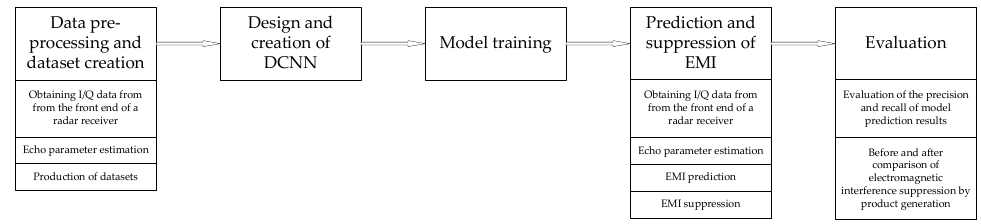
Figure 1. Experimental procedure.